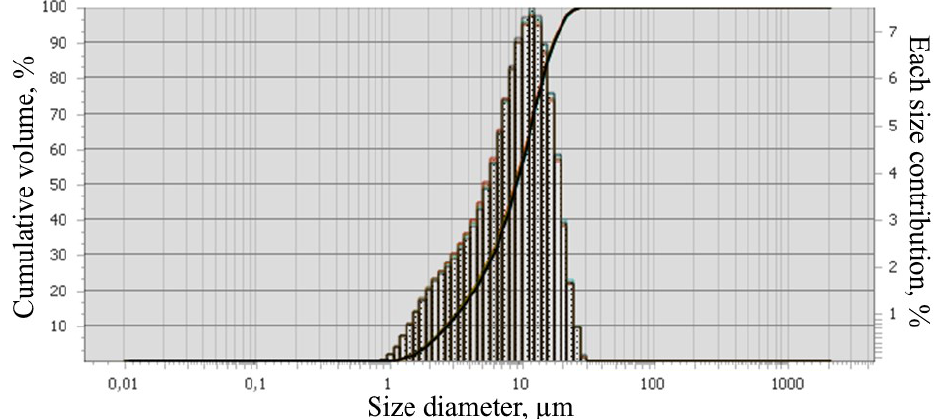
Figure 4. Particle size distributions of the initial coal ash.